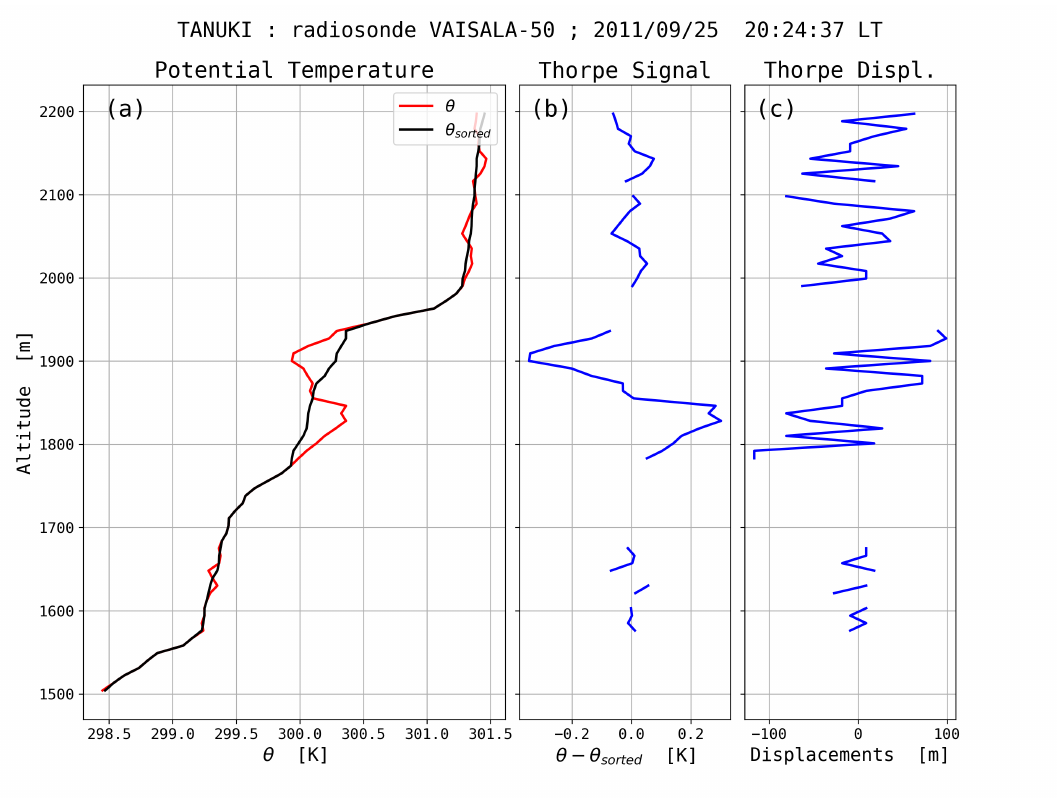
Figure 1. ( a ) Observed ( θ ∗ ) and sorted ( θ s ∗ ) potential temperature profiles. ( b ) Thorpe’s signal: θ ∗ − θ s ∗ . ( c ) Thorpe’s